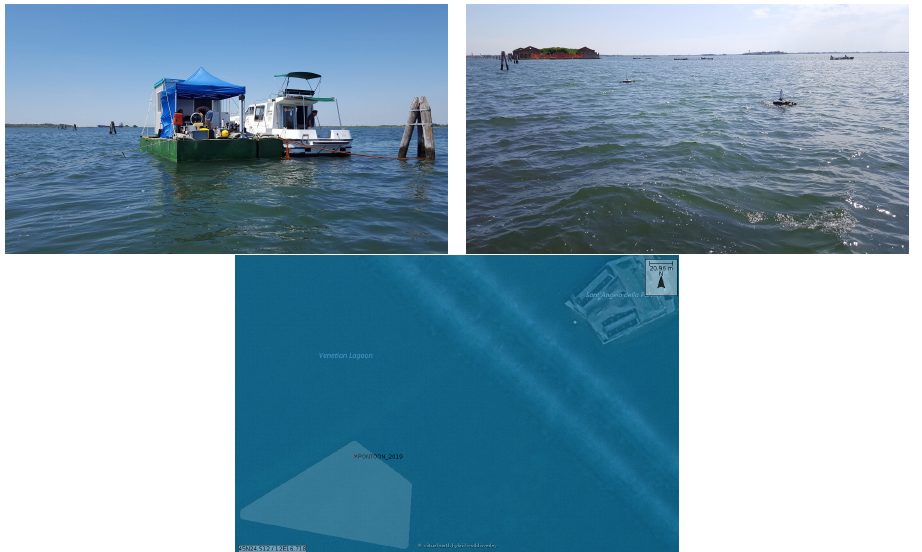
Figure 22. On-site experiments in the Venice lagoon. The pontoon off which robots were deployed ( top left ), field trials in progress ( top right ), mission supervision interface showing highlighted experiment area ( bottom ).